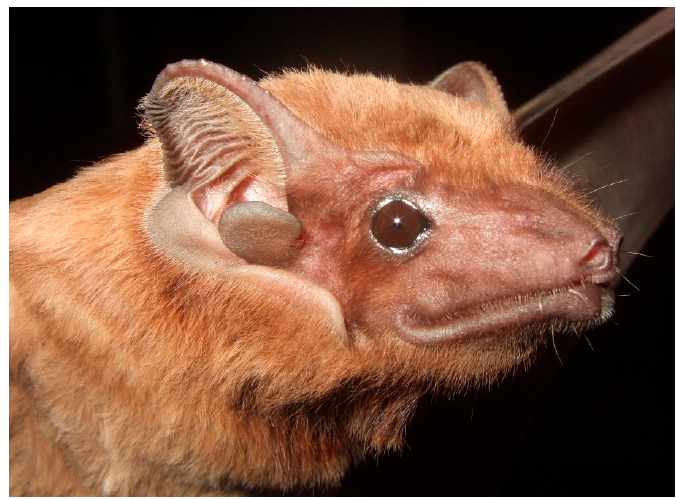
Figure 4. Taphozous melanopogon , adult male. Photograph by Vu Dinh Thong.